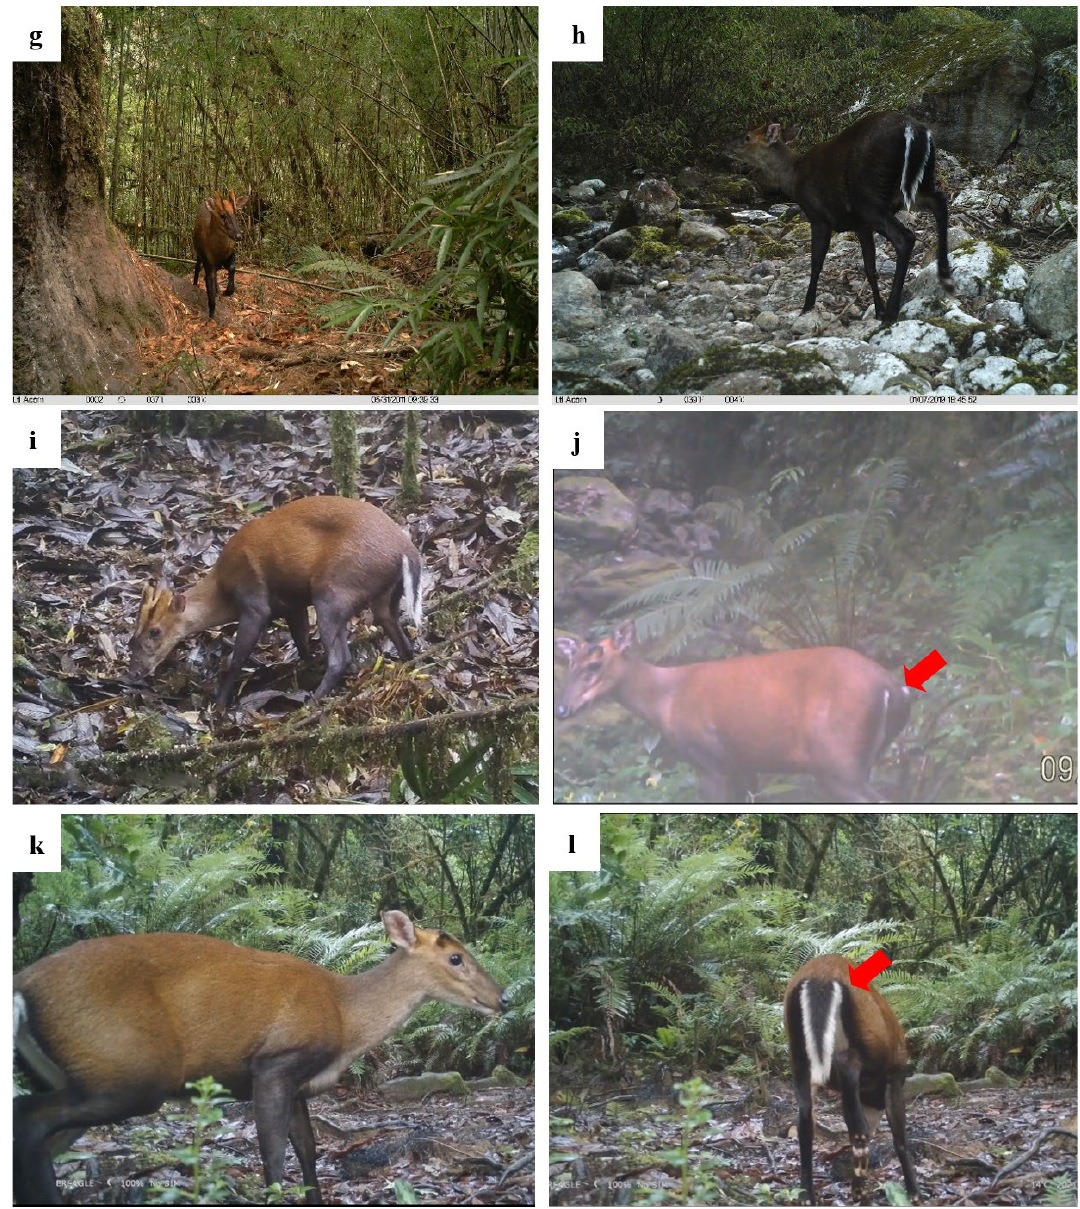
Figure 2. The three muntjac species present in the Tibetan Yarlung Zangbo Grand Canyon National Nature Reserve. ( a – d ) Red muntjac ( Muntiacus vaginalis ); ( e – h ) Gongshan muntjac ( M. gongshanensis ); ( i – l ) Fea’s muntjac ( M. feae ). Note: ( a , c , e , g , i ) are male, and ( b , d , f , h , j – l ) are female. The red arrows pointed at the tails indicate the biggest difference between M. feae and M. vaginalis .